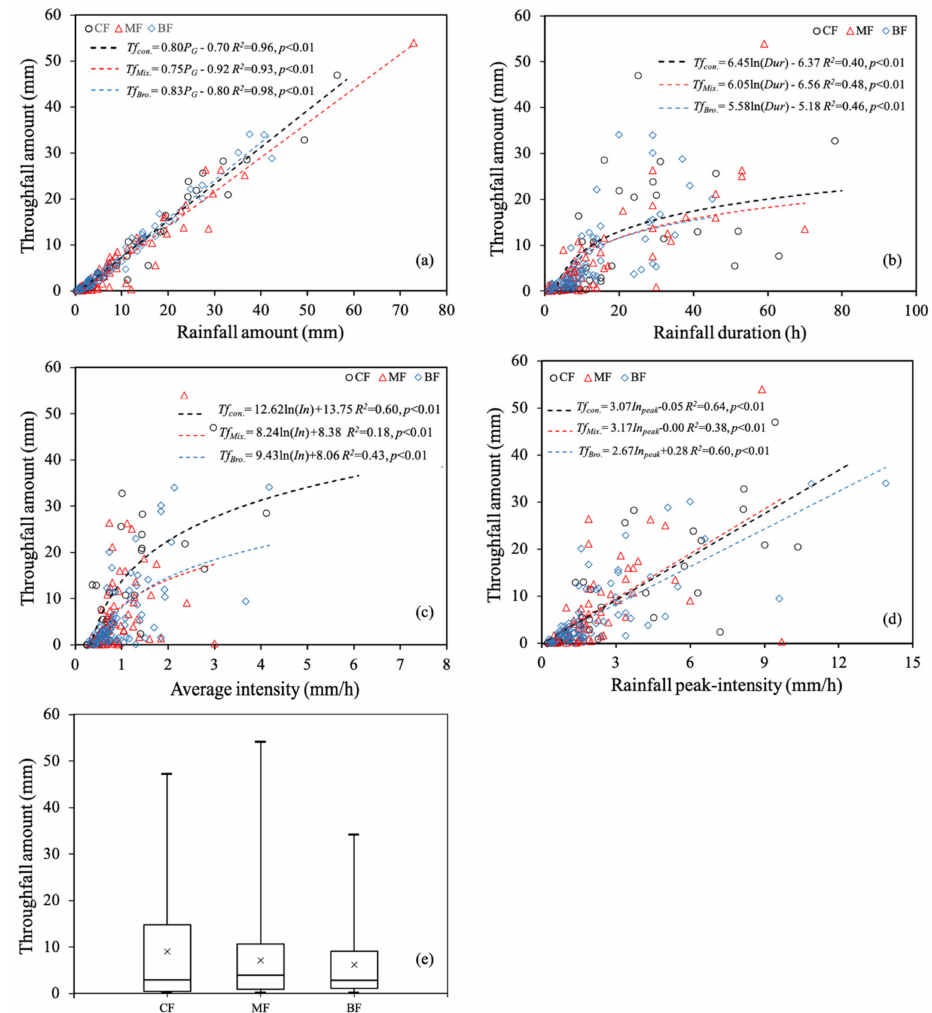
Figure 4. Throughfall amount as a function of individual rainfall amount ( a ), duration ( b ), average intensity ( c ), and peak intensity ( d ). Box plots in ( e ) depict the mean, median, 25th, and 75th percentile values of throughfall amount in CF, MF, and BF. The whiskers show the maximum and minimum values of throughfall